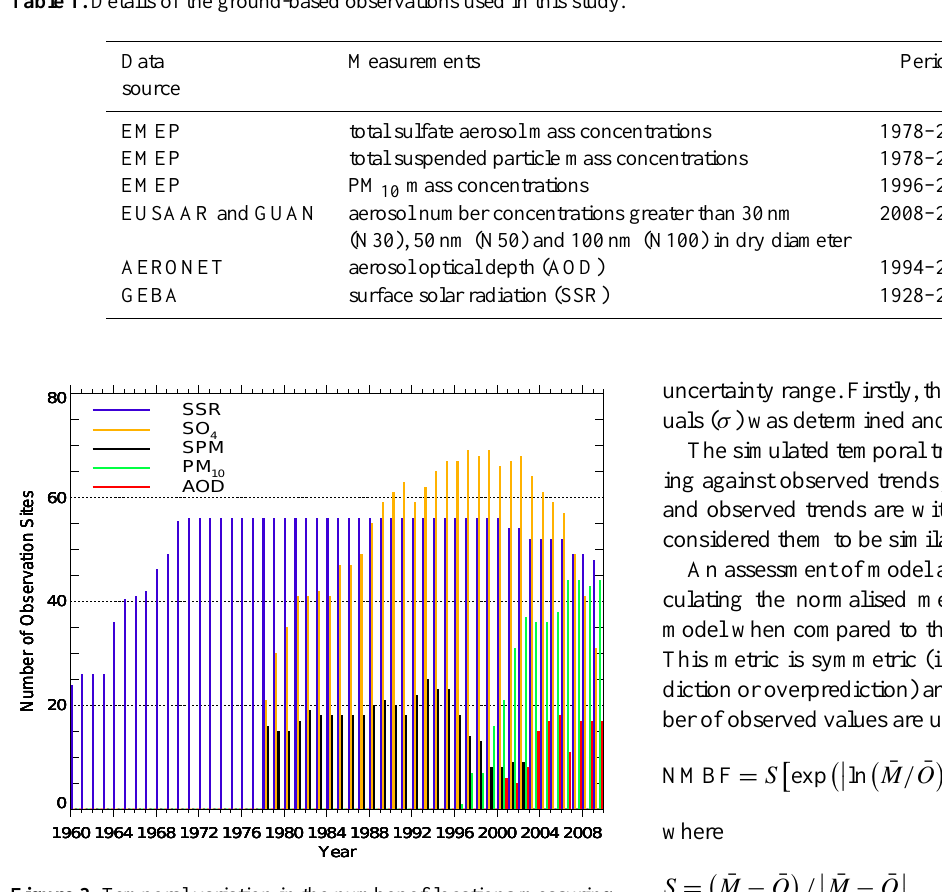
Figure 3. Temporal variation in the number of locations measuring surface solar radiation (SSR), sulfate aerosol mass (SO 4 ), total sus- pended particle mass (SPM), PM 10 mass and aerosol optical depth